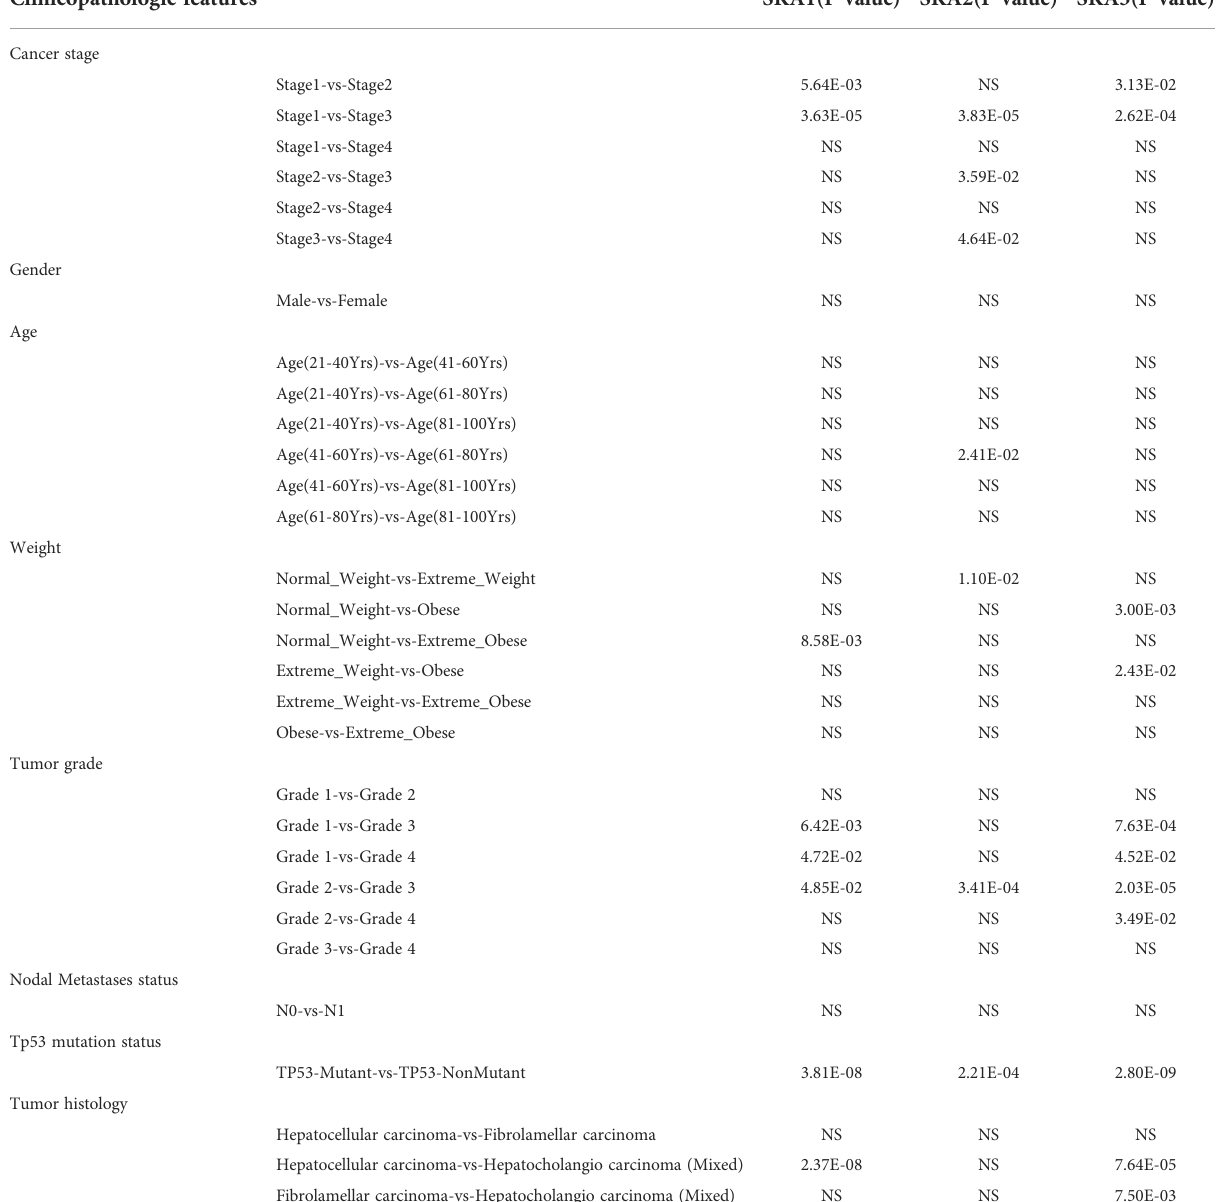
TABLE 1 The relationships between SKA1/2/3 expression and clinicopathological features in HCC patients in the UALCAN database. Clinicopathologic